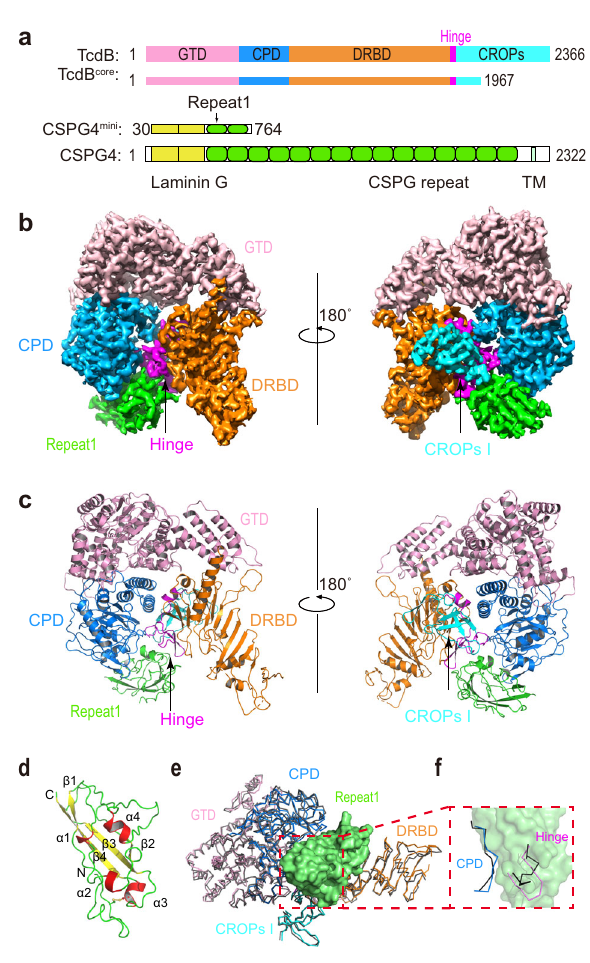
Fig. 1 Overall structure of the TcdB – CSPG4 complex. a Schematic diagrams showing the domain structures of TcdB and CSPG4, as well as the domain boundaries for TcdB core and CSPG4 mini used for cryo-EM studies. GTD: glucosyltransferase domain, CPD: cysteine protease domain, DRBD: delivery and receptor-binding domain, CROPs: combined repetitive oligopeptides domain, Hinge: a key fragment between the DRBD and CROPs that mediates structural communications among all four domains of TcdB. CSPG4 is composed of two predicted laminin G domains, 15 CSPG repeats, a transmembrane domain (TM), and a cytosolic region. b The 3.17 Å resolution cryo-EM map of the TcdB core – Repeat1 complex segmented and colored as shown in a . c Cartoon representation of the structure of the TcdB core – Repeat1 complex that is shown in similar orientations and color schemes as that in b . d The structure of Repeat1 of CSPG4 with the disul fi de bond shown as sticks. e The structure of the TcdB core – Repeat1 complex was superimposed to TcdB holotoxin (PDB: 6OQ5). The Repeat1- bound TcdB is colored as shown in a and the unliganded TcdB is colored black with its CROPs II – IV omitted for clarity. The TcdB-bound Repeat1 is shown as a green surface model. f Repeat1 triggers local structural changes in the CPD and hinge of TcdB upon binding. For clarity, only residues 569 – 577 in the CPD and residues 1803 – 1812 in the hinge are shown in the context of Repeat1 (green